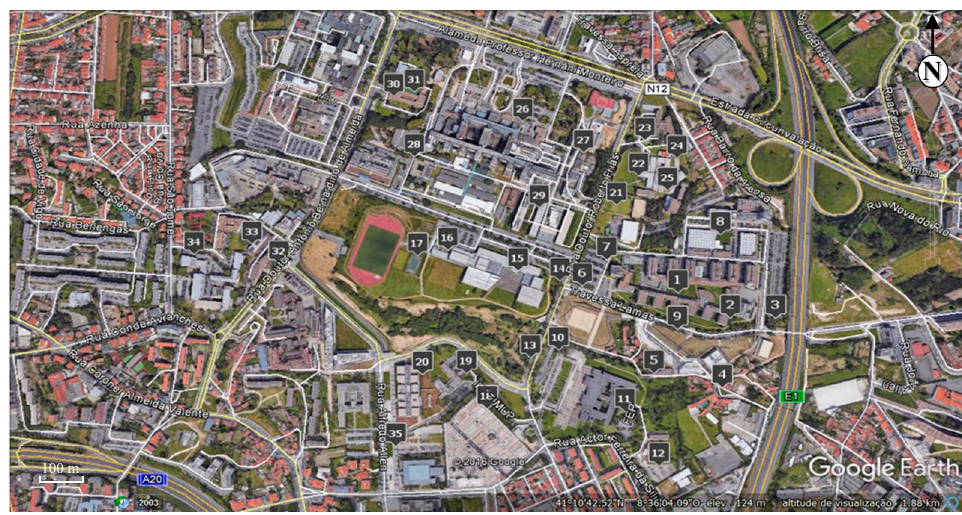
Figure 3. Sampling area within the Asprela's University Campus (Google Earth, 2017). Table 2. Sampling campaigns